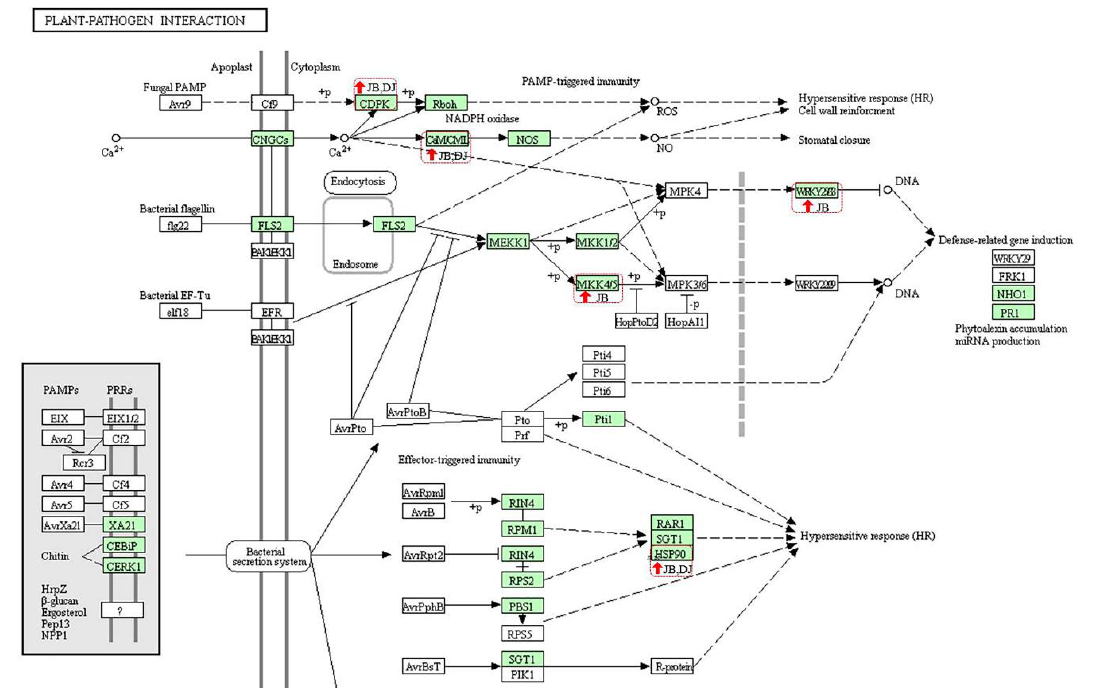
Figure 5. Biochemical pathway of plant-pathogen interaction derived from the KEGG website. DEGs matching the enzymes/proteins involved in the pathway were indicated with red marks. Proteins in green boxes are: CEBiP, Chitin elicitor binding protein; CERK1, chitin elicitor receptor kinase 1;CNGCs, cyclic nucleotide gated channel 10; FLS2, Flagellin-Sensitive 2; CDPK, calcium-dependent protein kinase 1;Rboh, respiratory burst oxidase-like protein; CAMCML, calcium-binding protein CML;NOS, nitric-oxide synthase;WRKY25, WRKY transcription factor 25; MERK1, mitogen-activated protein kinase kinase kinase 1; MKK1/2, mitogen-activated protein kinase kinase 1;MKK45, mitogen-activated protein kinase kinase 4/5;NHO1, glycerol kinase; PR1, pathogenesis-related protein 1; Pti1, pto-interacting protein 1; RIN4, RPM1-interacting protein 4; RPM1, NB-ARC domain-containing